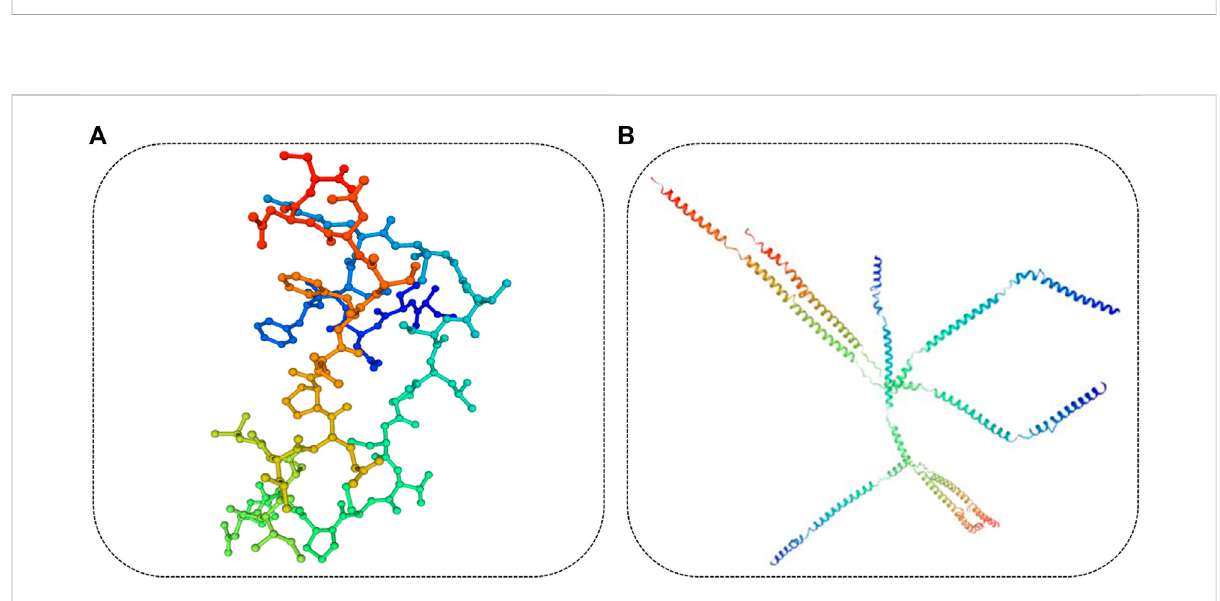
Three-dimensional structure of the protein. (A) . The three-dimensional structure of KRTAP3-1 was predicted based on the amino acid sequence. (B) . The three-dimensional structure of KRT85 was predicted based on the amino acid